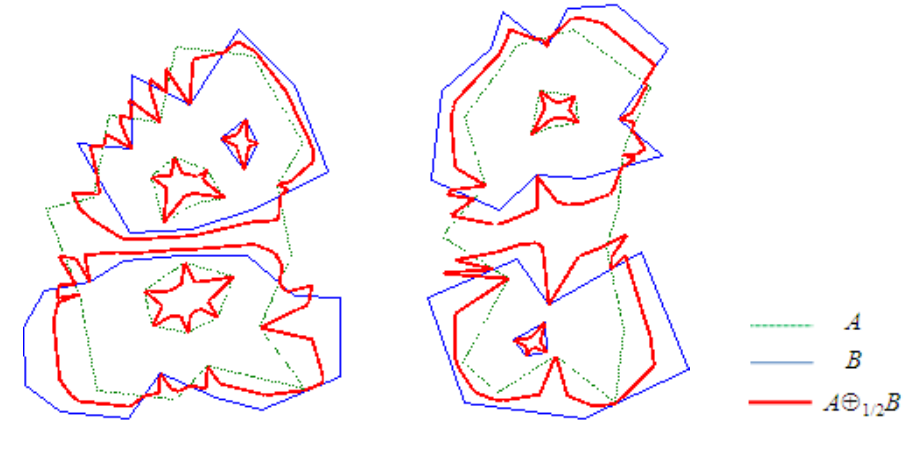
B , where A, B are sets with piecewise linear Figure 4. A ⊕ 1 / 2